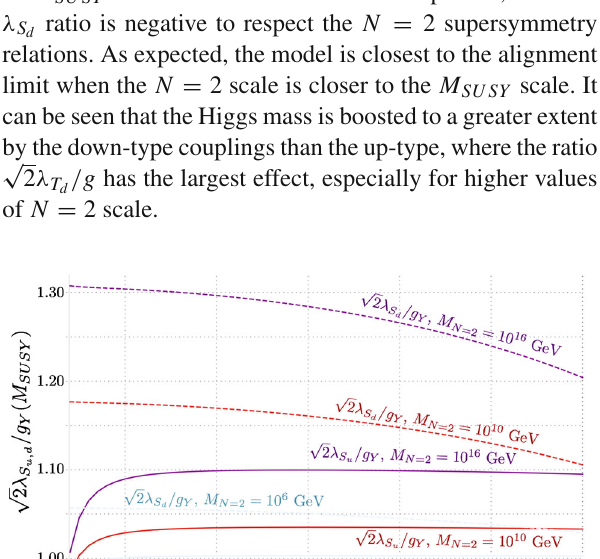
β at the M SUSY